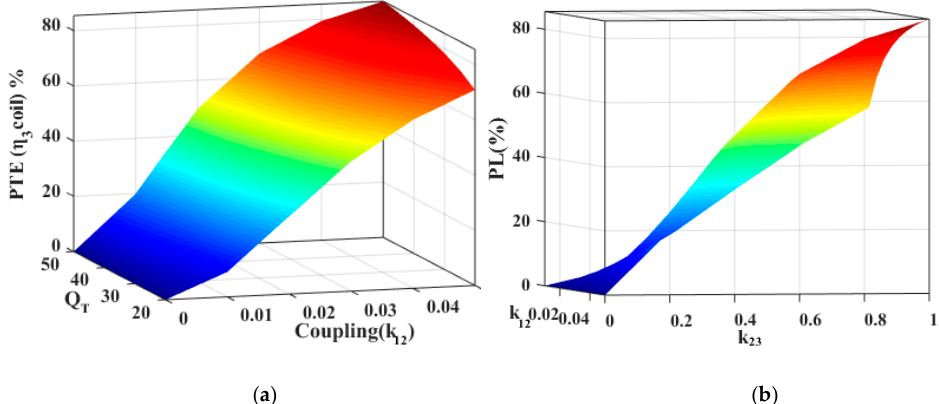
Figure 3. Three coil circuit response ( a ) Power transfer efficiency; ( b ) Power delivered to load.